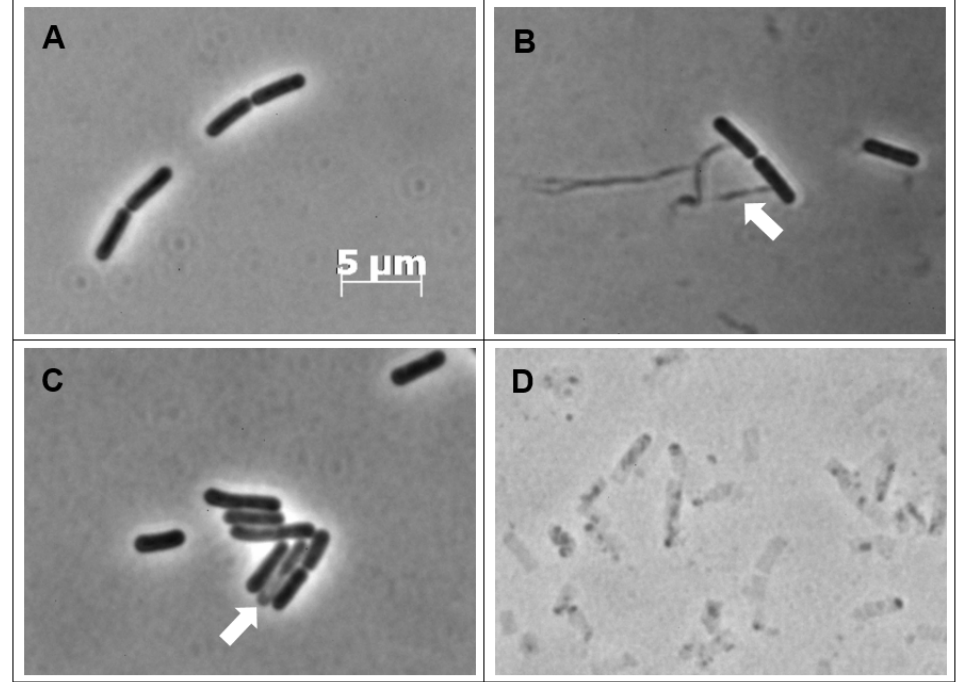
Figure 4. Phase-contrast images of CBCA-treated B. subtilis cells. B. subtilis cells in exponential phase (OD 600 0.1–0.3) were not treated ( A ) or treated with CBCA at 0.25 × MIC ( B ) 0.4 × MIC ( C ) or 1 × MIC ( D ). At 30 min, aliquots were obtained and washed with PBS to remove remaining compound. Bacterial cell suspensions were deposited on agarose pads for live phase-contrast microscopy with the Zeiss AxioPlan 2 Upright Light Microscope and 100 × objective. Image analysis was performed with AxioVision (Zeiss). White arrows indicating insoluble intracellular material leaking from bacteria ( B ) or cells in the process of lysis ( C ).